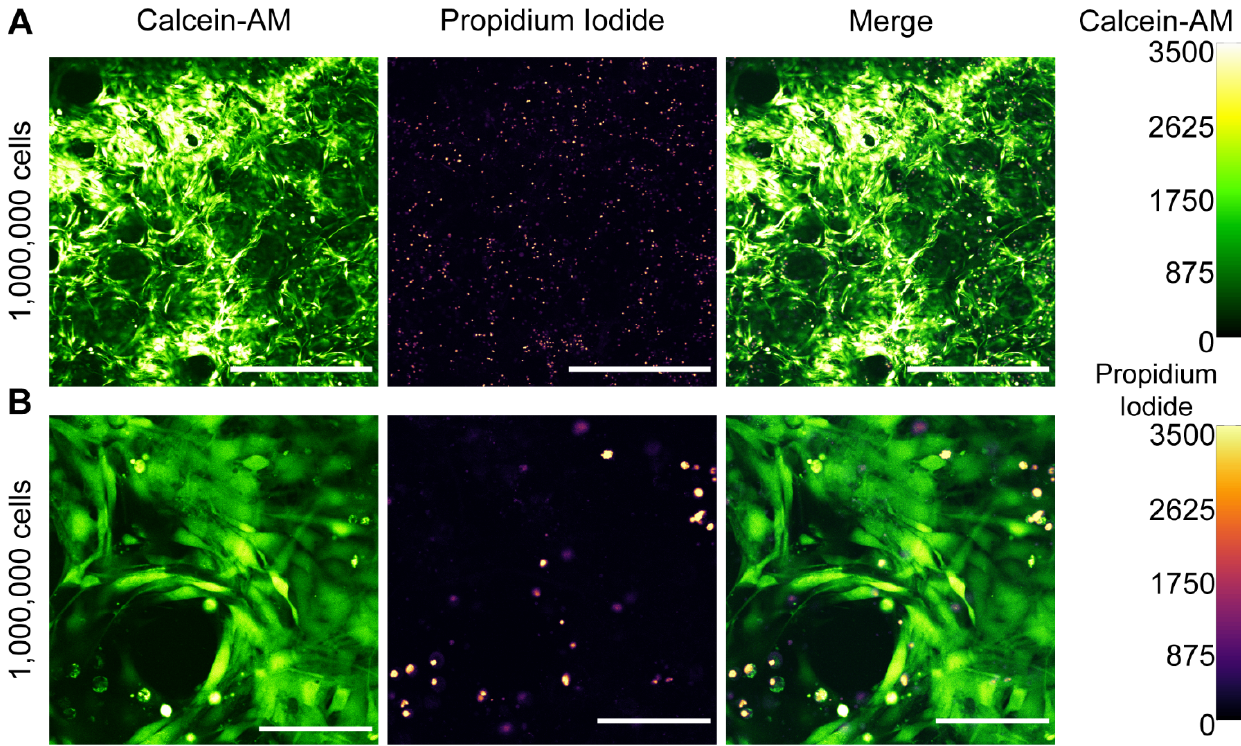
Figure 2. Sufficient initial cell densities are needed for C2C12 cell viability and spreading in 3D collagen scaffolds. ( A ) Low magnification overview of C2C12 viability 48 h post-seeding; ( B ) high magnification zoom-in. Calcein-AM intensities to assess cell viability and PI staining are visualized by the false color look-up tables green hot and mpl-inferno, respectively (right). Brightness and contrast were equally adjusted across conditions. Scale bars in panel A represent 500 µm, scale bars in panel B represent 100 µm.